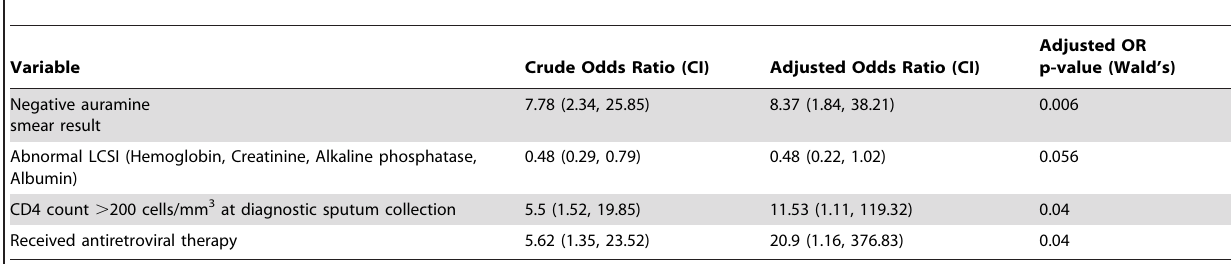
Table 2. Regression Analysis Associated with Survival among XDR-TB patients with HIV-coinfection (n =129).